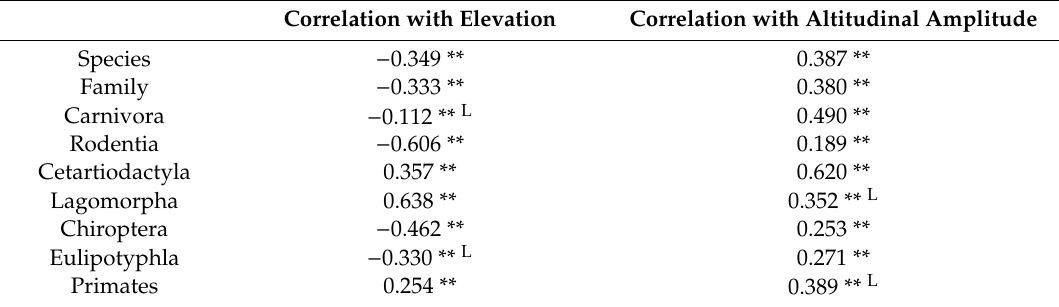
Table 4. Correlation coe ffi cients between mammalian richness and